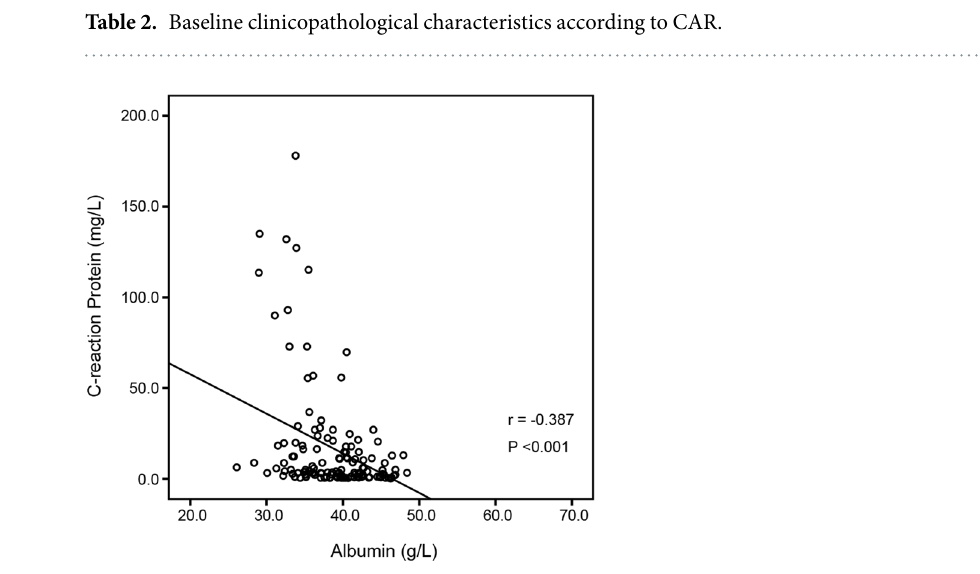
Figure 2. The correlation between CRP and